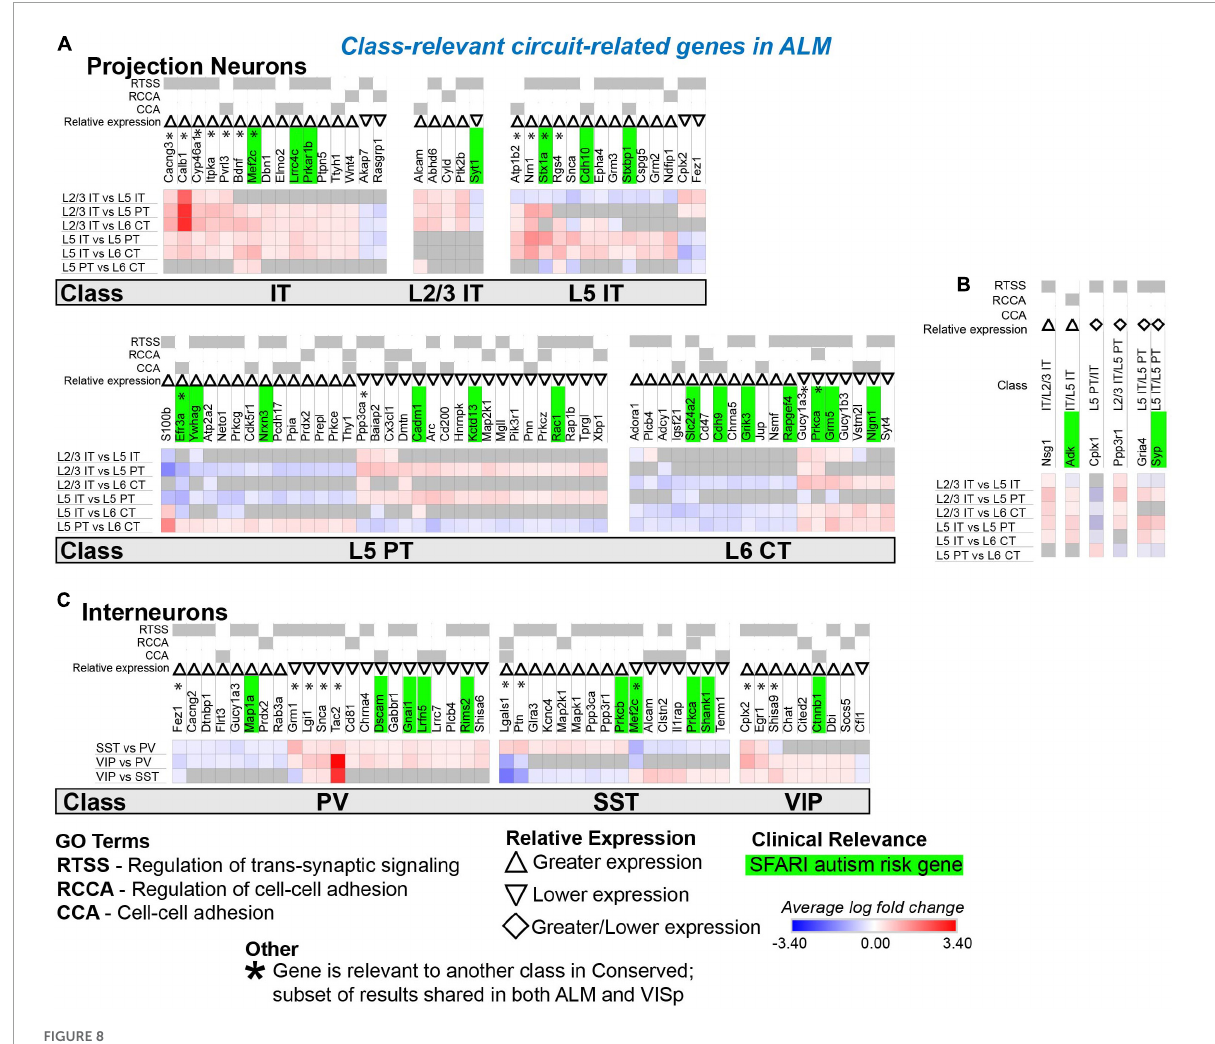
FIGURE8 Circuit-related genes only relevant to neuronal classes in ALM. Each row (e.g., L2/3 IT vs. L5 IT) presents the results of differential expression tests between neuronal classes. Differential expression results are always relative to the first neuronal class in a comparison (e.g., L2/3 IT in ‘L2/3 IT vs. L5 IT’). Gray indicates no significance in differential expression. Shades of red and blue indicate the log fold change of average expression for tests that were statistically significant. Up and down arrows denote whether expression was higher or lower relative to the other classes. (A) Circuit-related genes relevant to single classes of excitatory projection neurons. We created the new class “IT” for genes that were relevant to both L2/3 IT and L5 IT classes. (B) Circuit-related genes relevant to multiple classes of excitatory projection neurons. The diamond symbol indicates that a gene is relevant to two different classes: it is equivalent to an up arrow for the first gene and a down arrow for the second. For example, the L5 PT class has greater expression of Cplx1 relative to the other classes, and the IT class has lower expression relative to the L5 PT and L6 CT classes. (C) Circuit-related genes relevant to single classes of inhibitory interneurons. CCA = cell-cell adhesion; RCCA = regulation of cell-cell adhesion; RTSS = regulation of trans-synaptic signaling.